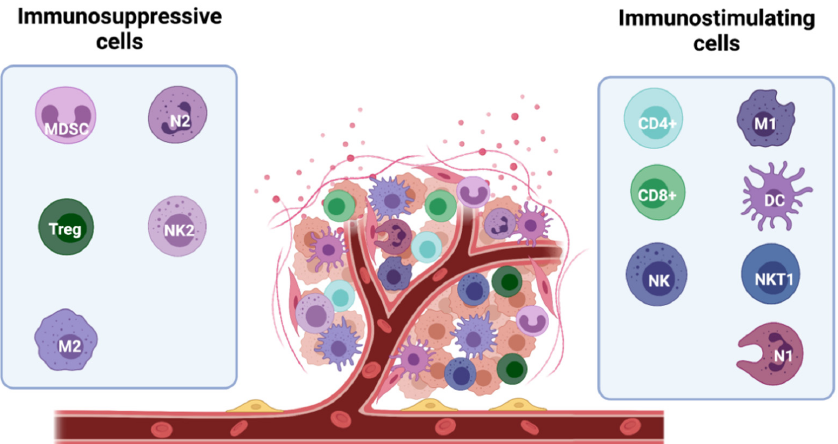
Figure 3. Major players in the immune microenvironment of breast cancer. Subtypes of immune cells can elicit both tumour-promoting and tumour-suppressing effects. The anti-tumour activity is mainly driven by immunostimulating immune cells, including M1 macrophages, CD8 + and CD4 + lymphocytes, NK and NKT1 cells, and DCs and N1 neutrophils. They secrete cytokines and soluble factors which help fighting the tumour development (including IFN γ , TNF α , IL-1 β , IL-2, and IL-12). In contrast, immunosuppressive cells, including myeloid-derived suppressor cells (MDSCs), mast cells (MCs), regulatory T cells (Tregs), type 2- polarized tumour-associated macrophages (M2-TAMs), and N2 tumour-associated neutrophils (N2-TAN) can be recruited to the tumour site counteracting the anti-tumour activity and facilitating tumour growth. These cells release immuno-inhibitory pro-tumour cytokines (TGF- β , VEGF, IL-6, IL-8, and